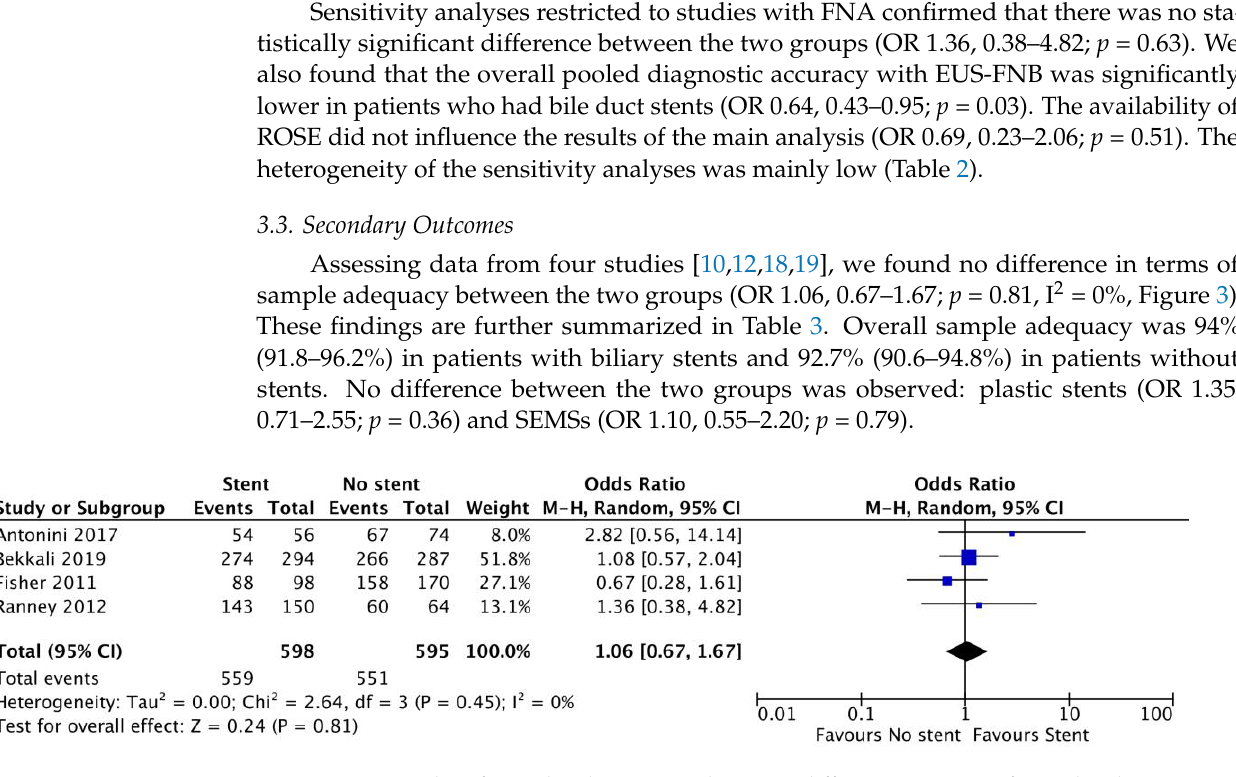
Figure 3. Forest plot of sample adequacy analysis. No difference in terms of sample adequacy was observed between patients with biliary stents and those without stents (OR 1.06, 0.67 – 1.67; p = 0.81, I 2 = 0%). References [10,12,18,19].